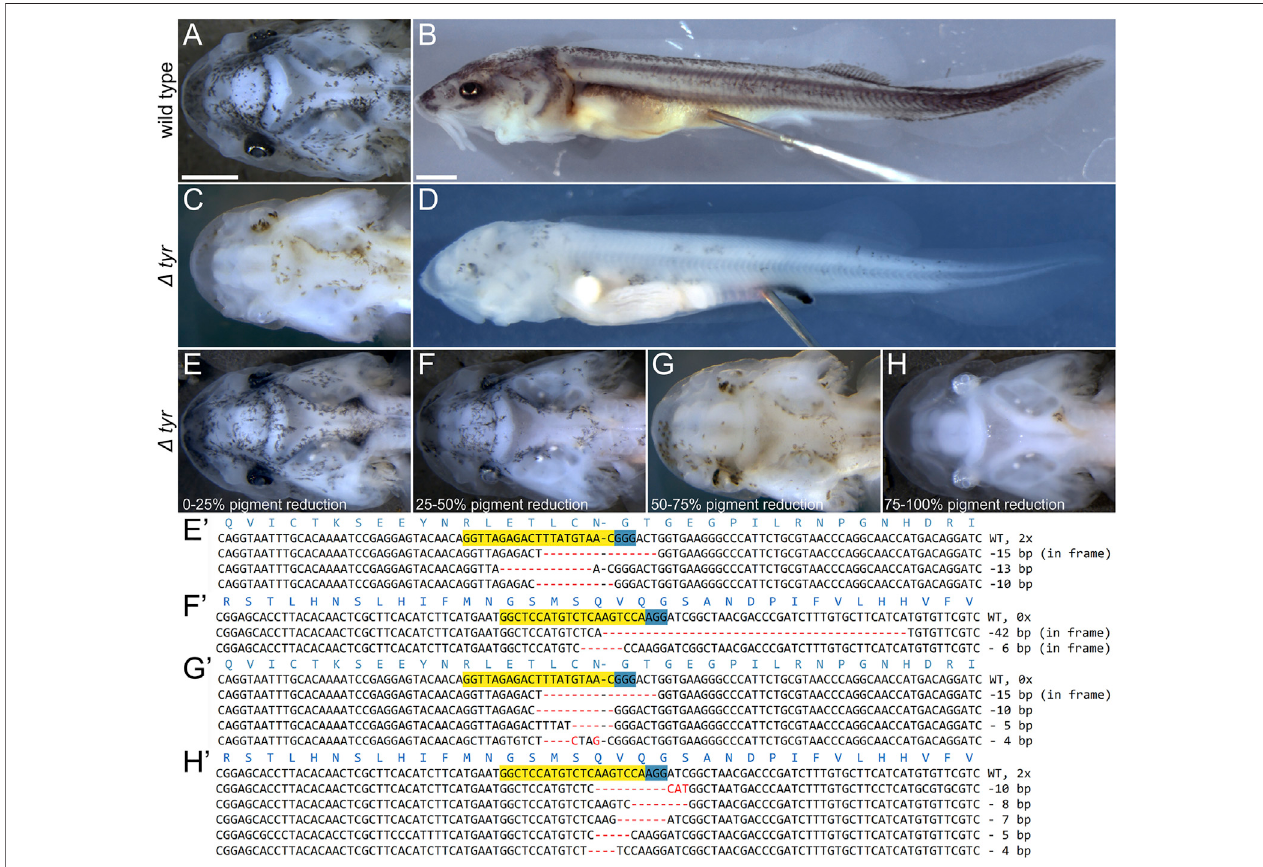
FIGURE 2 | Phenotypes and genotypes of Δ tyr sterlet larvae. Dorsal (A,C,E – H) and lateral (B – D) views of ~16 mm long larvae with anterior to the left. Wild type [WT; (A,B) ] and representative mutant (C,D) larvae and four mutant classes (E – H) and their genotypes (E 9 – H 9 ) . The CRISPR target sites and PAM on the forward sequences are highlighted in yellow and blue, respectively, and the red dashes and letters represent deletions, insertions, and polymorphisms relative to the WT sequence. Mutations in (E 9 ,G 9 ) , and (F 9 ,H 9 ) were introduced by tyr sgRNA three and sgRNA 4, respectively. Mutant and WT sequences were identi fi ed in all phenotype classes (see also Supplementary Figure S1 ), while sequencing of larvae portrayed on panels (F,H) only returned mutant sequences (as was the case of 3/ 11 mutant larvae). Scale bars (same in A + C + E-H and B + D) represent 1 mm.